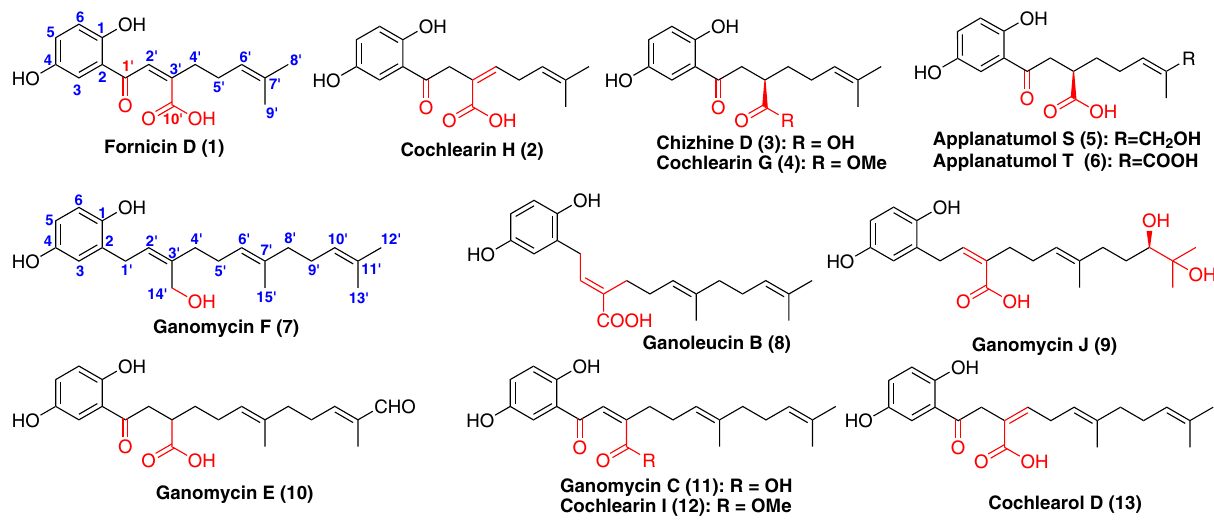
Fig. 1 Structures of GMs with a 10-carbon or 15-carbon